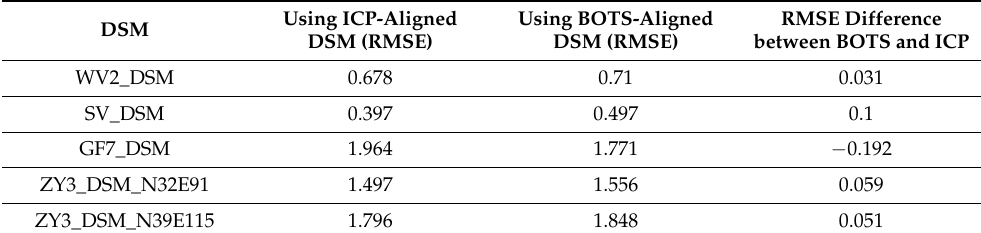
Figure 10. DSM elevation accuracy evaluation. Table 4. RMSE statistics of DSM elevation residuals (unit: m).